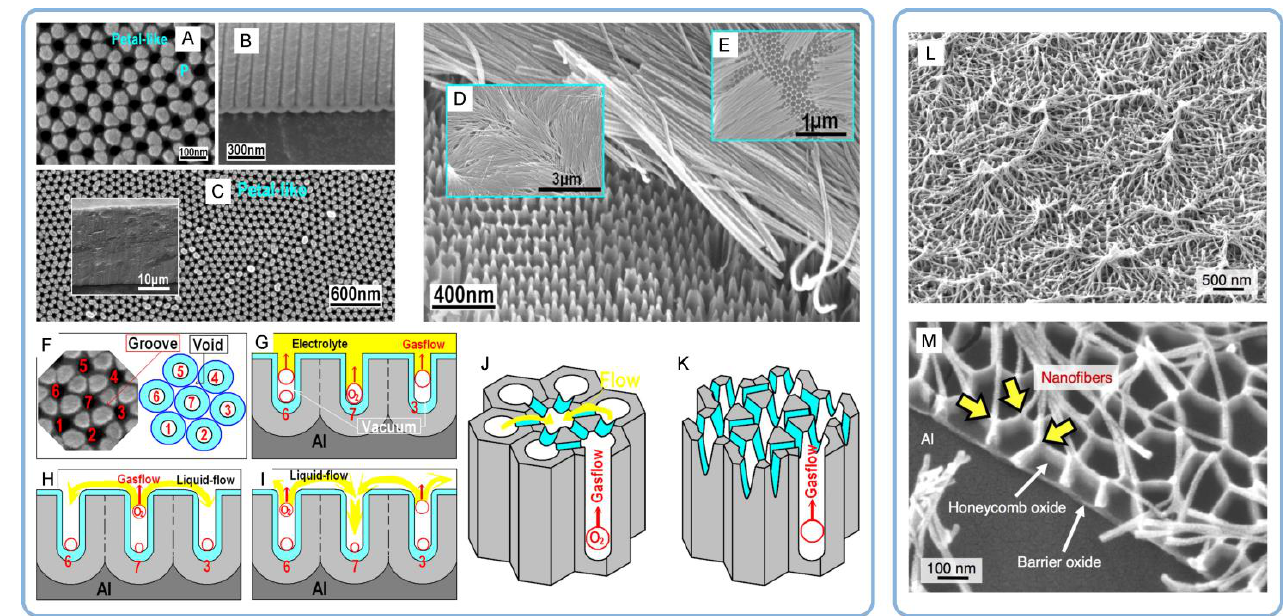
Figure 35. SEM images of PAA layers obtained from a 3 wt % H 2 C 2 O 4 solution at 4 °C and 40 V which show a petal-like micro-pattern on the porous side ( A – C ), and anodic alumina nanofibers synthesized using 6 wt % H 3 PO 4 at 20 °C and 80 V ( D , E ). A formation mechanism based on the “plastic flow” and the “oxygen bubble mold” models ( F – K ) has been proposed for these two new types of structures by Fan et al. (Ref. [154]). Kikuchi et al. (Ref. [11]) have reported the use of concentrated pyrophosphoric acid solution at 20 °C and 75 V for the synthesis of a similar type of anodic alumina nanofibers ( L – M ). The results presented in Refs. [11,154] suggest that the range of suitable anodizing conditions for the formation of alumina in such nanofibrillar form can be possibly further expanded. Reproduced with permissions. Copyrights 2014 Nature and 2017 Elsevier.